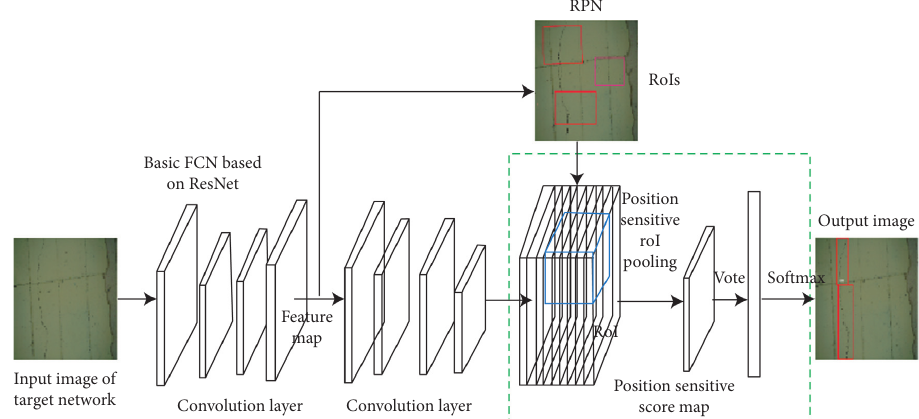
Figure 10: The architecture of R-FCN network for bridge defects recognition.